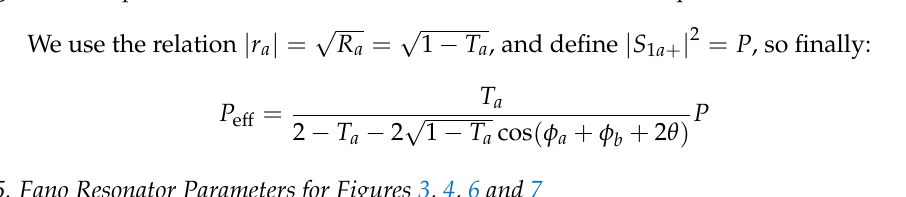
Figure 10. Coupled Fano resonators with shifted zero-transmission